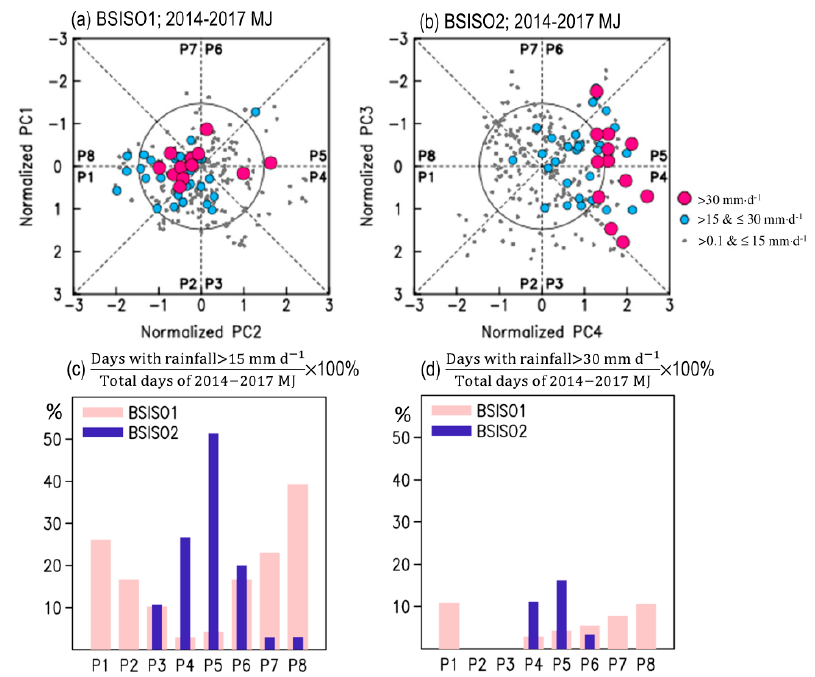
Figure 5. Phase diagram of ( a ) BSISO1 and ( b ) BSISO2 with the value of daily rainfall area averaged over Taiwan (120–122 ◦ E, 22–25.5 ◦ N), during the periods of May and June 2014 to 2017. The explanations of symbols in ( a , b ) are given in the right bottom of ( b ). ( c ) is the percentage of days with daily rainfall > 15 mm · d − 1 over the total days of 2014–2017 May and June, estimated for each phase (P1-P8 denotes phase 1-phase 8) of BSISO1 (pink bar) and BSISO2 (blue bar). ( d ) is similar to ( c ), but for the percentage of days with daily rainfall >30 mm ⋅ d − 1 over the total days of May and June 2014– 2017.